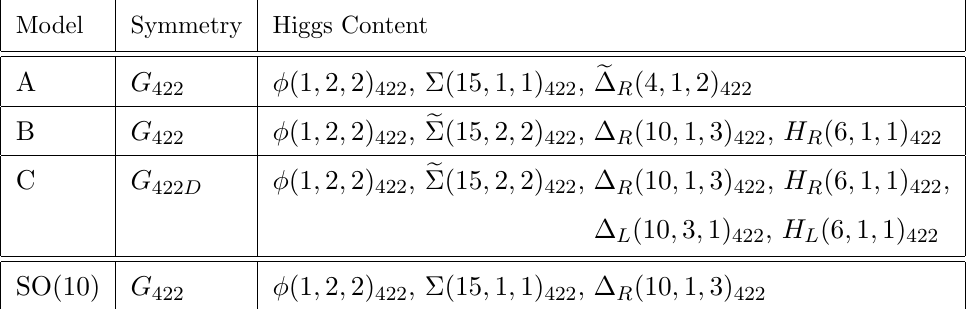
Table 1 . The scalar content of the three NCG based uni(cid:12)ed G 422 models proposed by